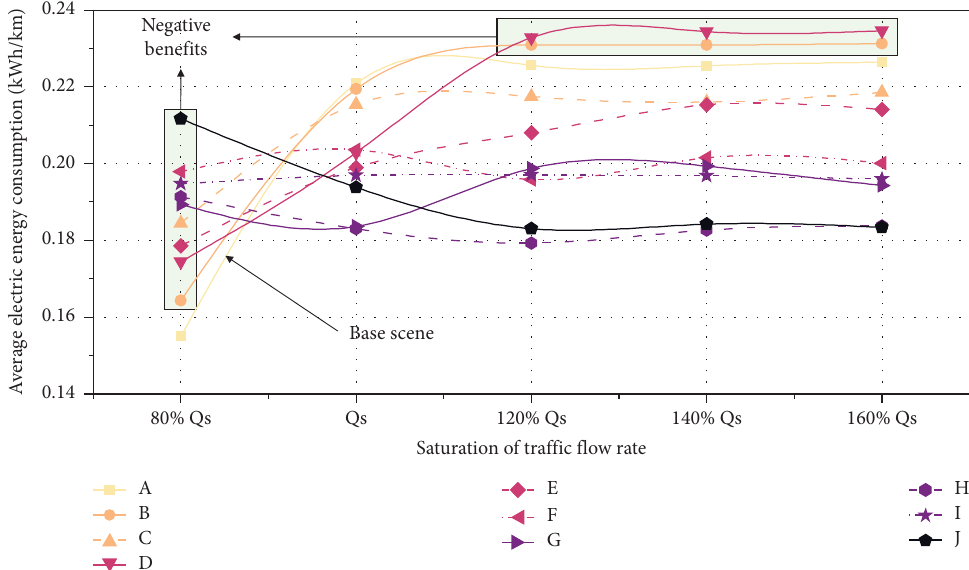
Figure 5: Te average electric energy consumption per vehicle per kilometer in diferent scenes under diferent trafc conditions. Table 5: Te value of electric energy consumption per vehicle per kilometer and its variation from scene A. Actual road Scenes